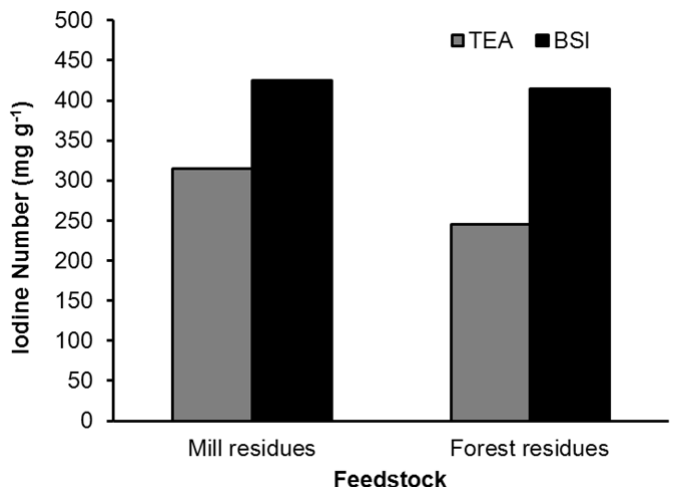
Figure 5. Iodine number of AC from biochar using a benchtop steam activation apparatus at 950 °C with steam injected at 15 psig.